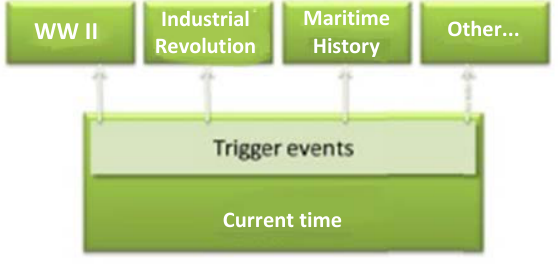
Figure 2. Alternate time trigger events start scenario action